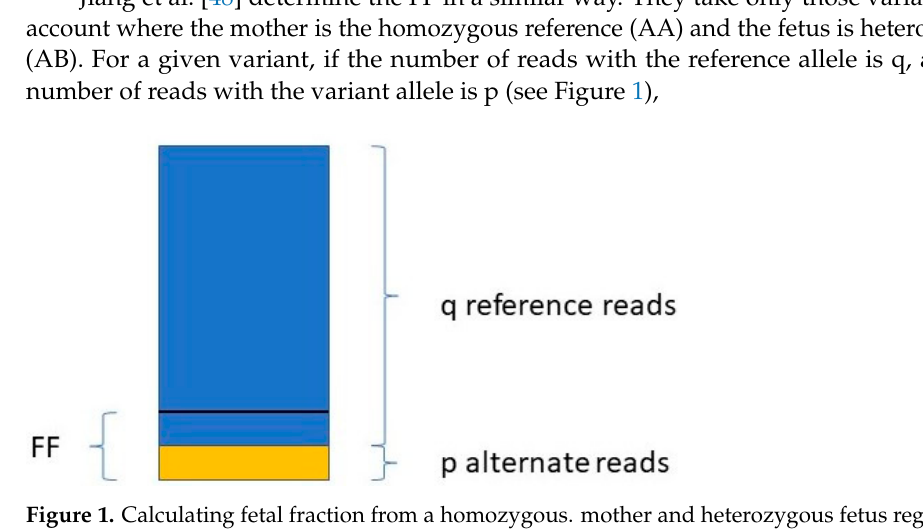
Figure 1. Calculating fetal fraction from a homozygous. mother and heterozygous fetus regarding a single SNP.